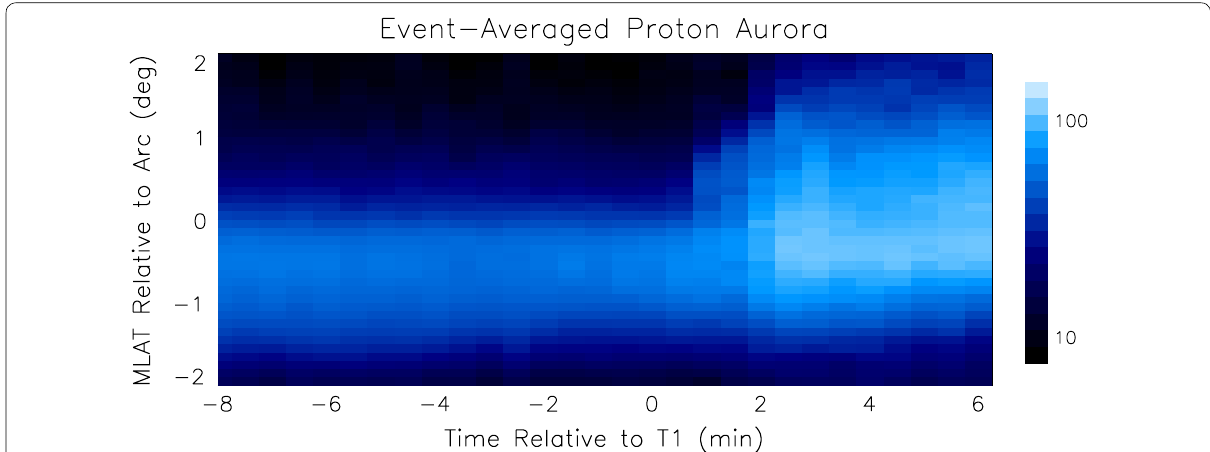
Fig. 9 Mean proton auroral profile versus relative time and MLAT. Proton auroral profiles averaged over our investigated events. x- axis denotes the time relative to T 1, while Y -axis denotes the MLAT relative to the center of